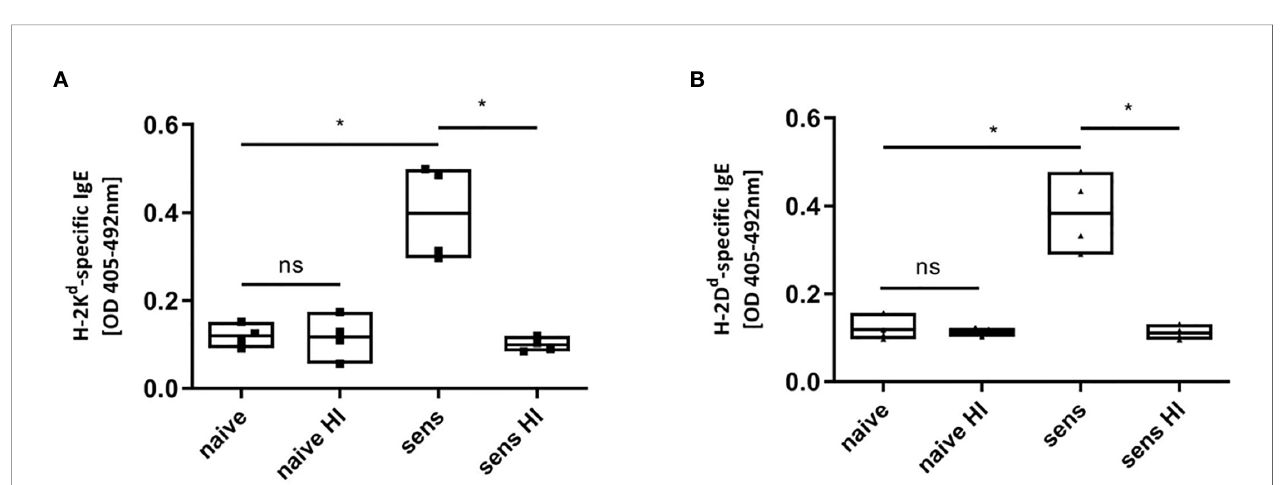
FIGURE 6 | Heat inactivation of sensitized serum. MHC-monomers (H-2K d , A ; H-2D d , B ) were incubated with heat inactivated serum, destroying potential existing IgE. Heat inactivation (HI) leads to a loss of signal of MHC-speci fi c IgE in C57BL/6 mice sensitized (sens) with a BALB/c (haplotype d) skin allograft. Results from two independent experiments are shown. (n=4 for sensitized and naïve) P values were calculated with Mann-Whitney U test. *P < 0.05, ns = not signi fi cant, P>